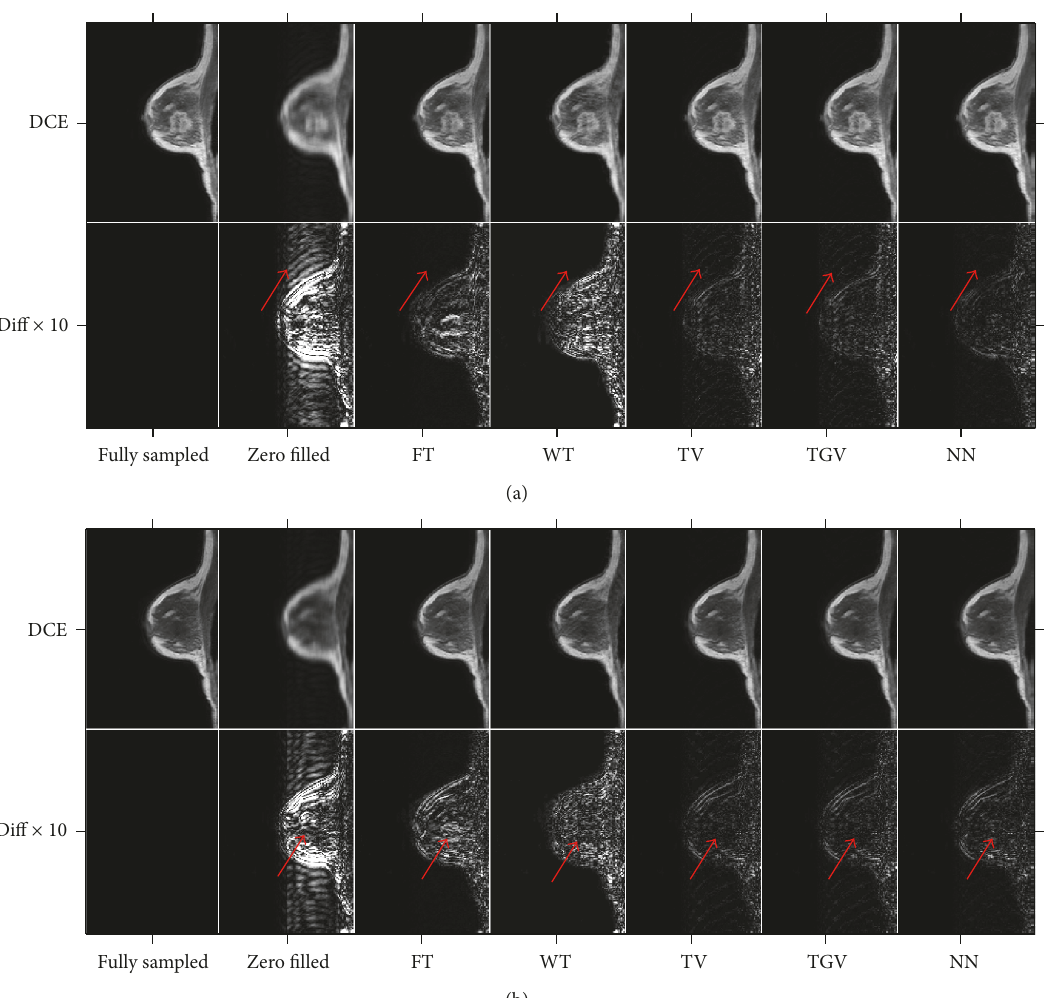
Figure 2: Reconstruction using the first mask for all five temporal constraints. (a) The 105th dynamic; (b) the first dynamic. In each subfigure, the first row shows the fully sampled, zero-filled, WT, FT, TV, TGV 2 𝛼 , and NN, respectively, and the second row is the corresponding difference images scaled up by a factor of 10. The aliasing artifacts are greatly reduced in the areas indicated by the arrows by TV, TGV, and NN.